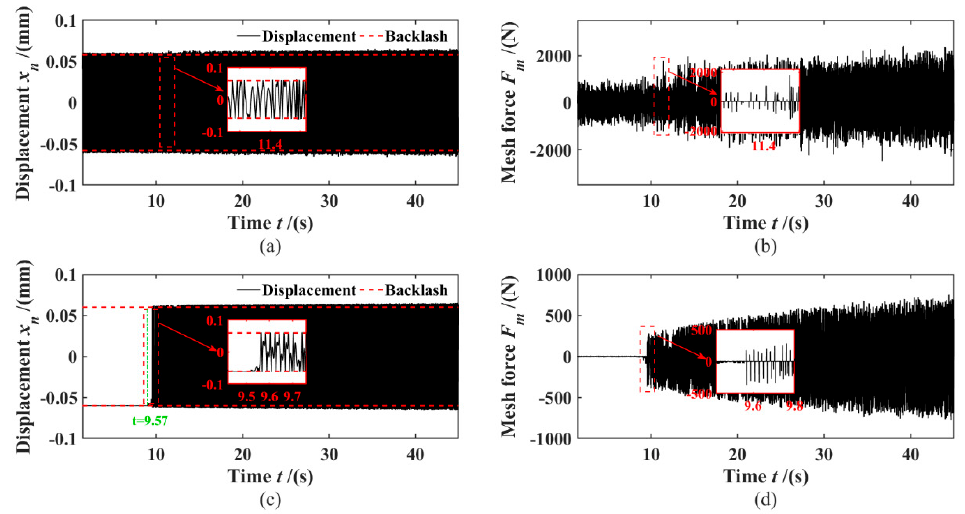
gear relative displacement; ( d ) 7th gear meshing force;.